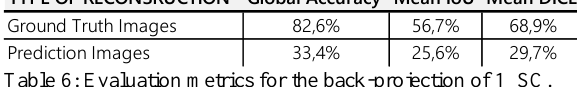
Table 6: Evaluation metrics for the back-projection of 1_SC.